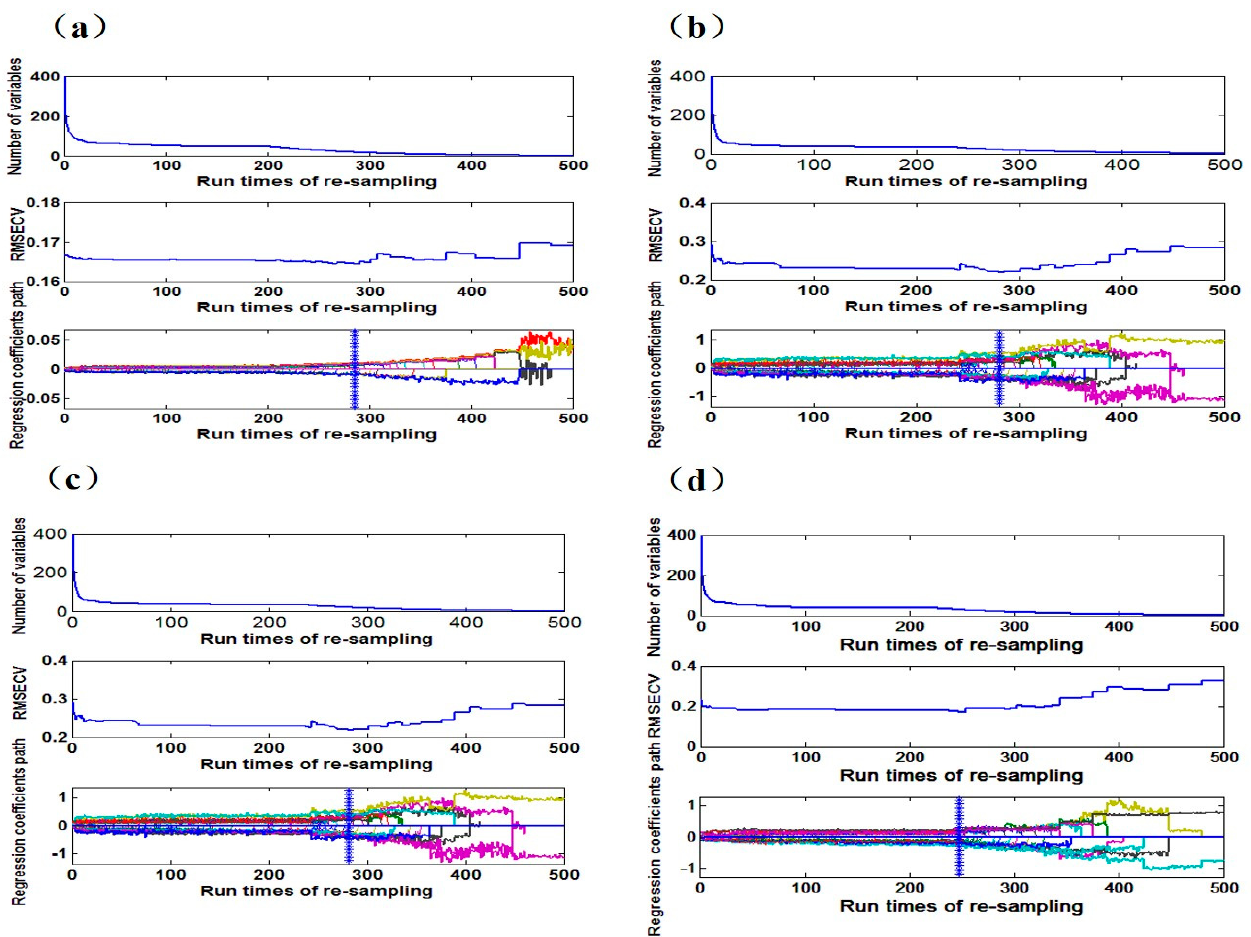
Figure 6. The variable selection process by competitive adaptive reweighted squares (CARS): ( a ) 50 °C drying; ( b ) 80 °C drying; ( c ) 95 °C drying; ( d ) 25 °C placement.